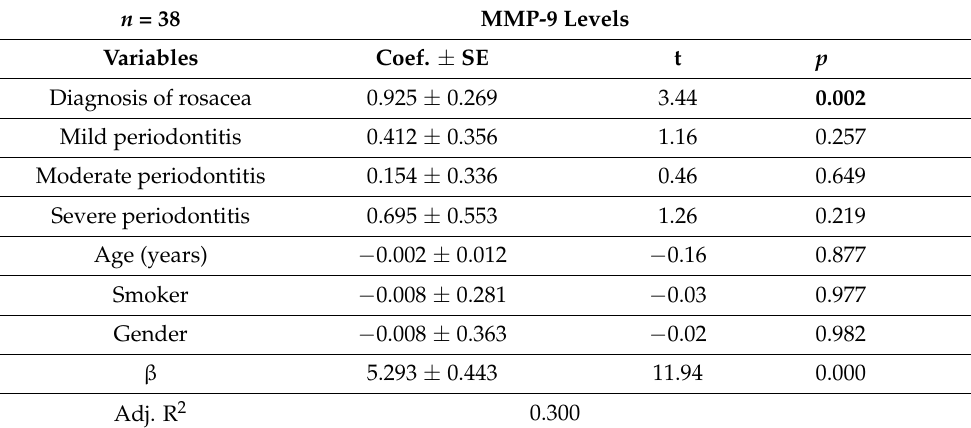
Table 2. Results of de multiple regression models for MMP-9 levels in gingival crevicular fluid in rosacea and control patients.